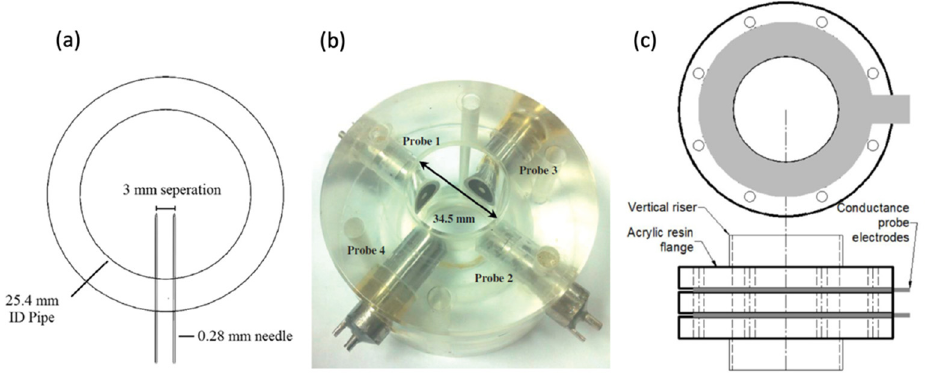
Figure 4. Some typical conductance probes. ( a ), Parallel-wire probes [109], 2021 ( b ), embedded concentric conductance probes [118], 2013 and( c ), ring-shaped probes [129], 2019. Figures are adapted with permission from the references, Elsevier.